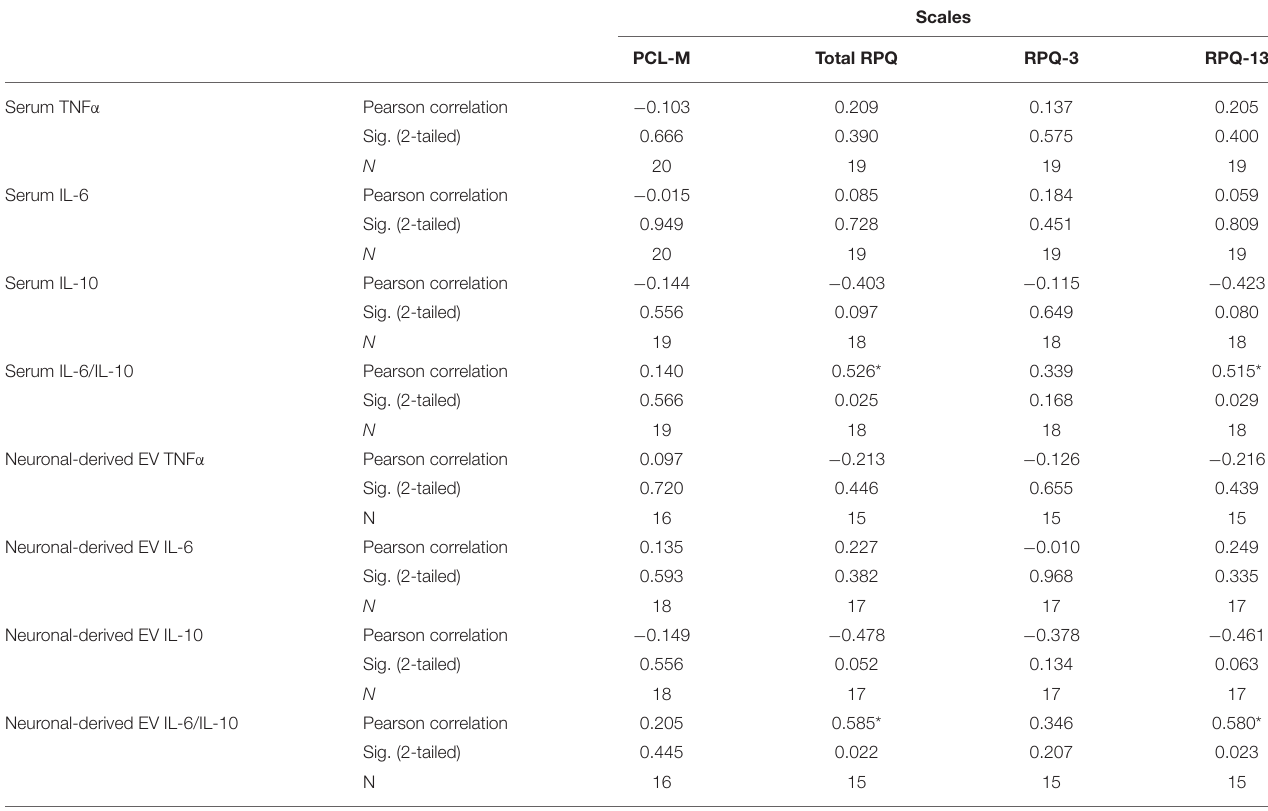
TABLE 2 | Pearson correlations of log-transformed biomarkers with PCL-M and RPQ